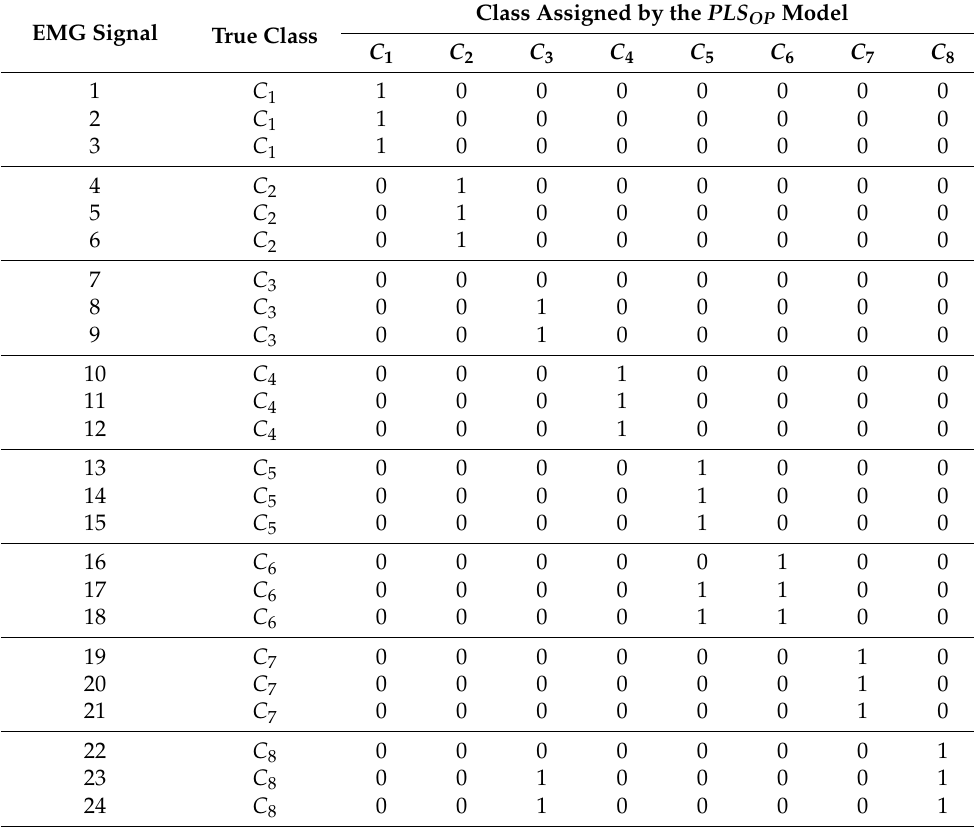
Table 3. Assignation matrix for the sEMG classes of the test dataset X TS . A 1 means assigned class and 0 not